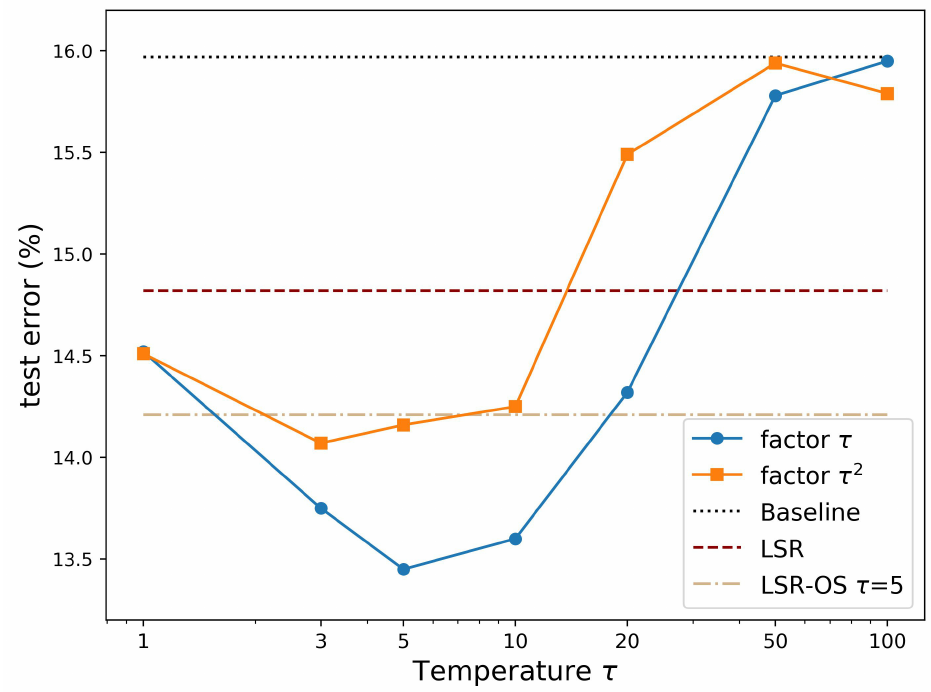
Figure 8. Graph of test error vs. temperature τ of nnet1 on the GTZAN dataset. Blue: LSR-OS-TC with factor τ ; orange: LSR-OS-TC with factor τ 2